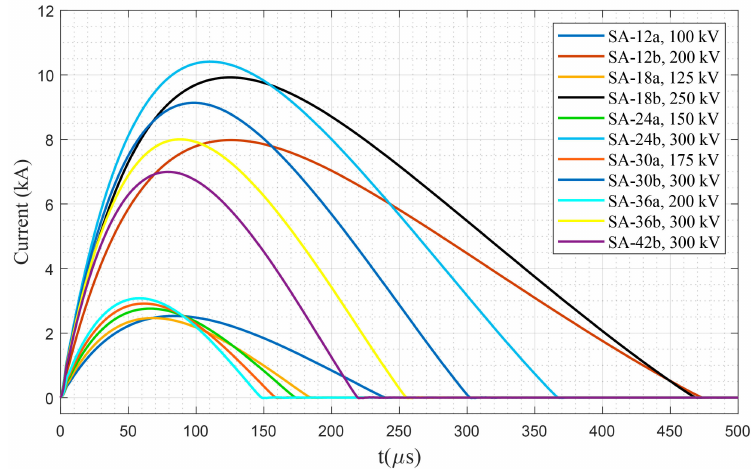
Figure 29. Comparison of the current flow through di ff erent surge arresters against the highest handleable lightning